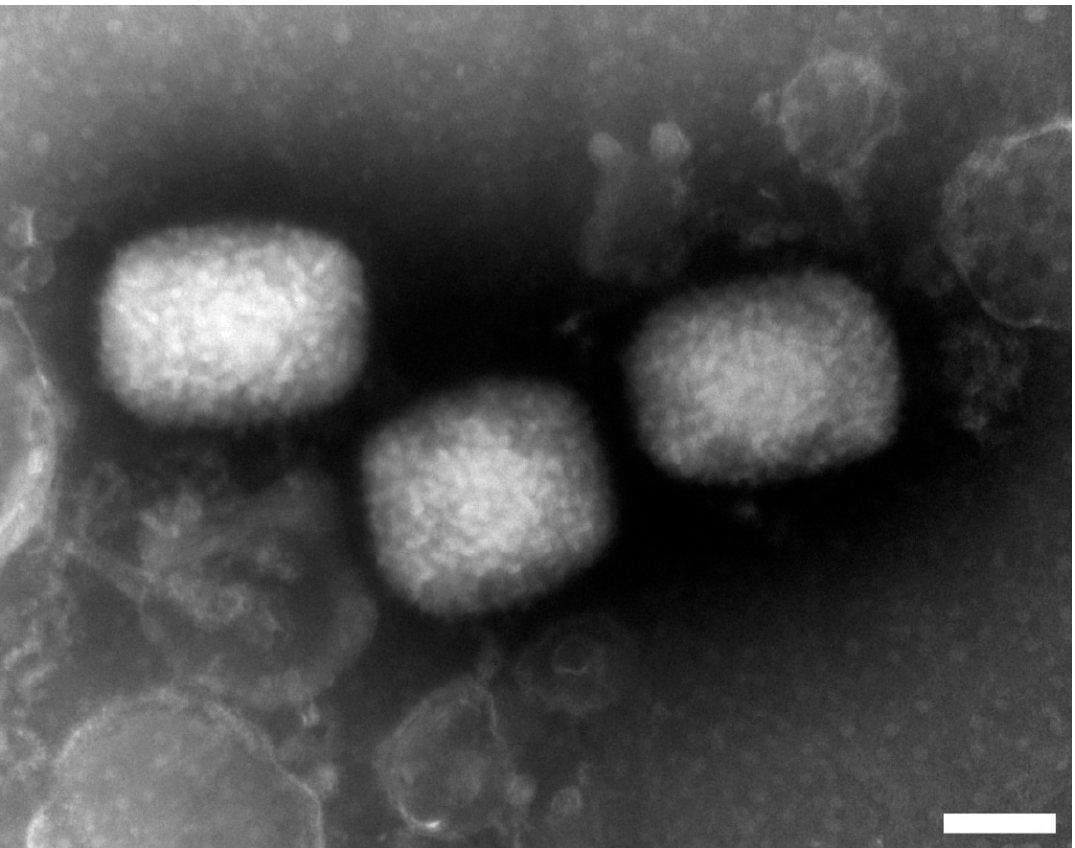
Figure 1. Orthopoxvirus particles. Transmission Electron Microscopy. magnification—150,000 × . The length of the white bar in the right bottom corner represents 100